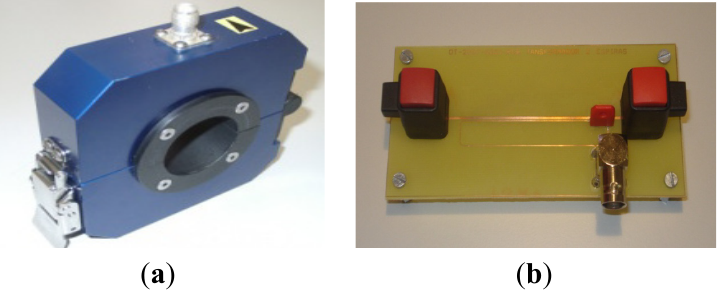
Figure 3. Two inductive sensors. ( a ) HFCT and ( b ) ILS.